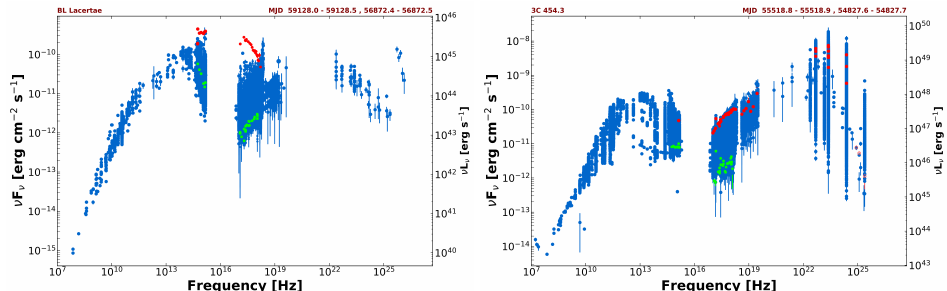
Figure 2. The SED of the HBL Mrk 501 ( left ) and the IBL PKS1424+240 ( right ) illustrating that most of the variability in these objects is in the X-ray band and translates into large shifts of the ν S energy. Red and green colours represent Swift UVOT and XRT simultaneous data during high peak and low luminosity states respectively.